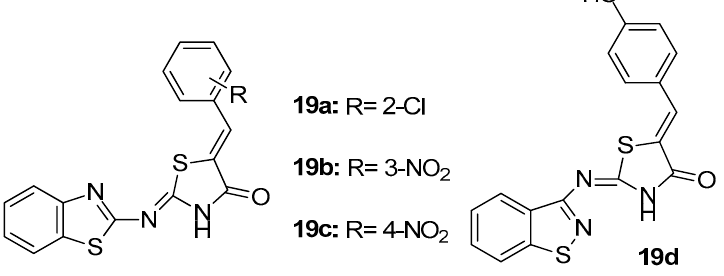
Figure 21. Chemical structures of benzothiazol-2-yliminothiazolidin-4-ones 19a – d .